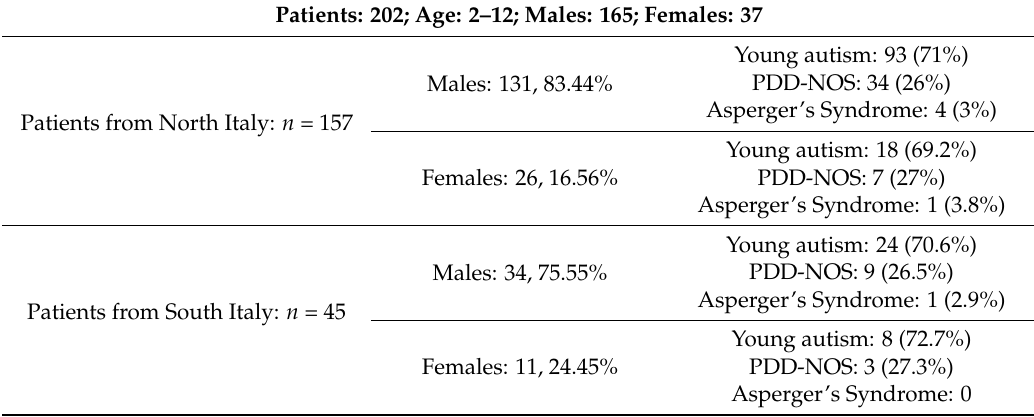
Table 4. Demographic data and diagnosis of autistic